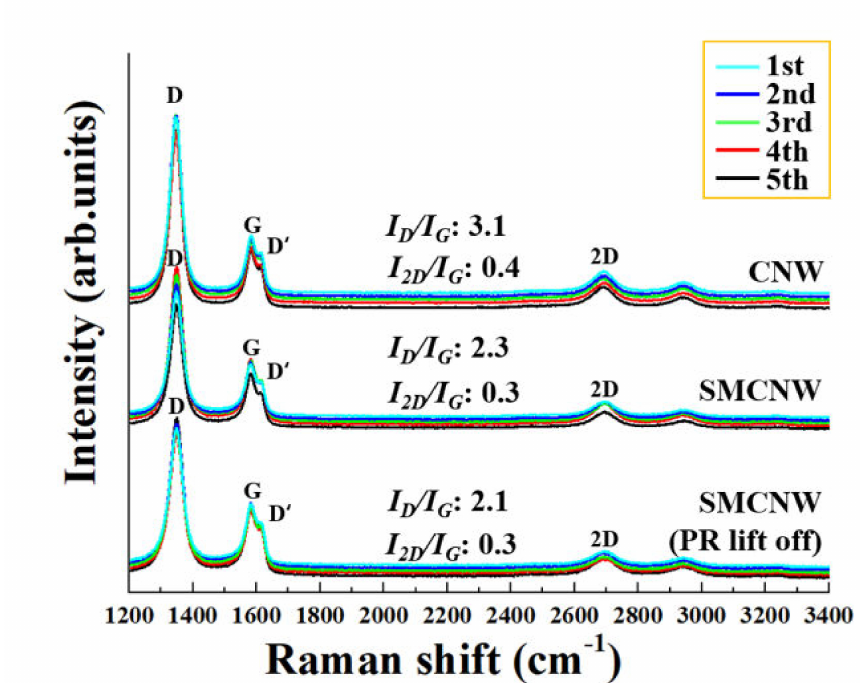
Figure 8. Raman spectra of the CNW, SMCNW, and PR-removed